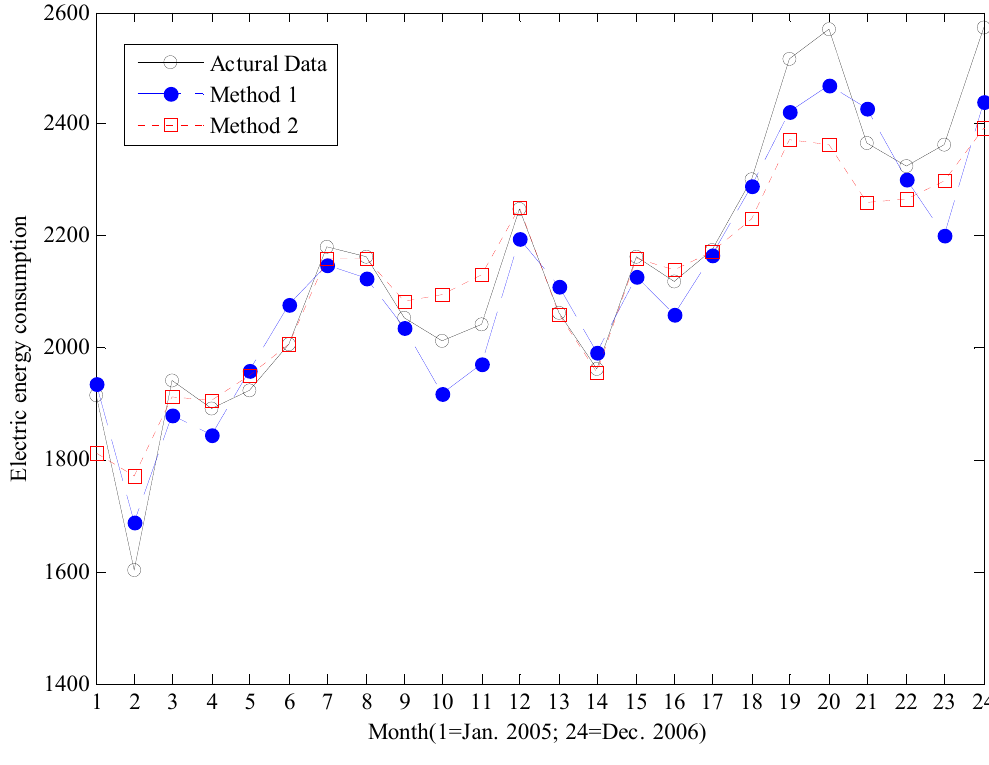
Figure 5. Curves of actual data based on the forecasting results of Methods 1 and